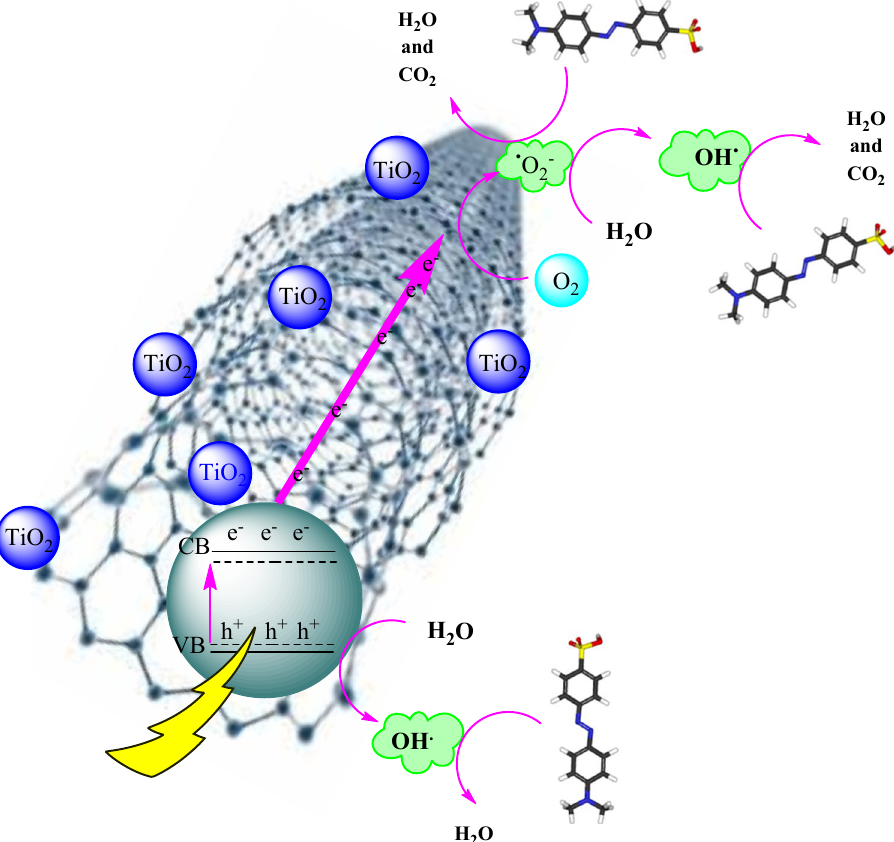
Fig. 6 A schematic of the pho- tocatalytic process of MCT#1 and